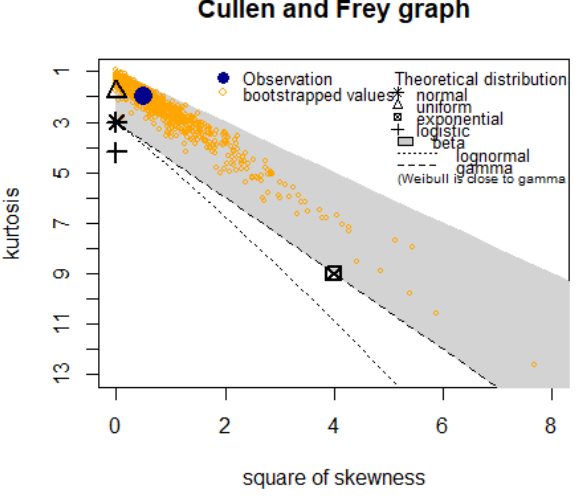
Figure 7. Estimated marginal distribution for HIV/AIDS for females.